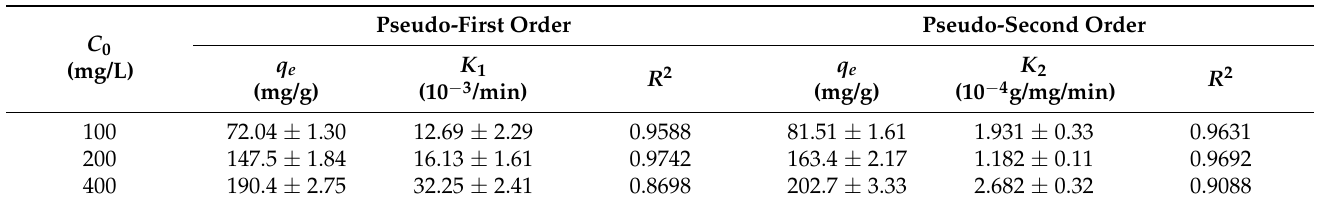
Table 1. Kinetic parameters of Cu (II) adsorption onto poly(acrylic acid/chestnut shell pigment) at temperature = 300 K, pH = 6, and adsorbent dosage = 1